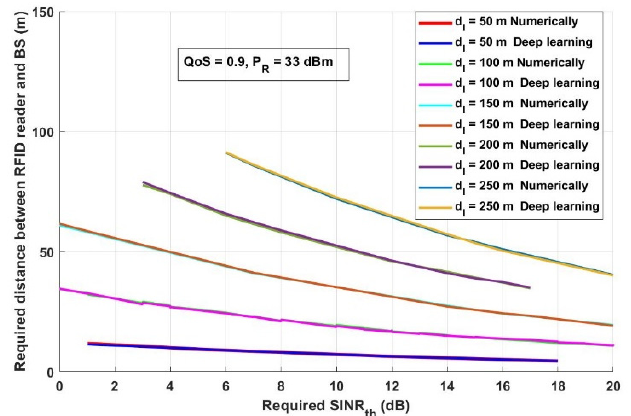
Figure 8. Required SINR th (dB) versus required distance between RFID and BS (m).